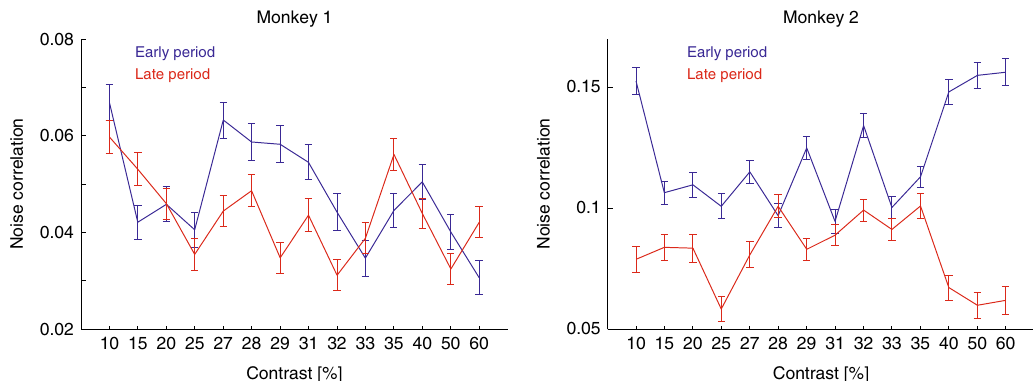
Fig. 6 Noise correlations as a function of training period and test contrast. Left column: Average noise correlation for all pairwise comparison for different test contrasts during early experimental sessions ( fi rst 5 days, blue) and during late experimental sessions (last 5 days, red). Error bars denote S.E.M. ( n = 29 and n = 20 per data point for monkeys 1 and 2,